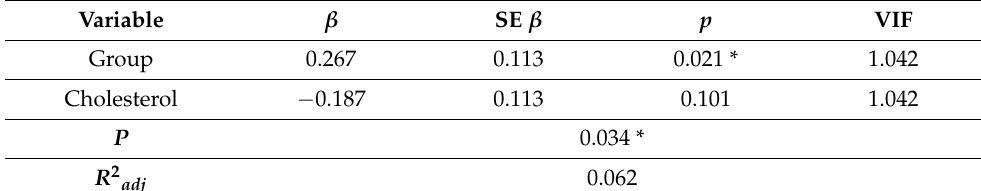
Table 3. Multiple regression analysis of the change in visual memory score and the intake of major nutrients. Variable β SE β p VIF Group 0.267